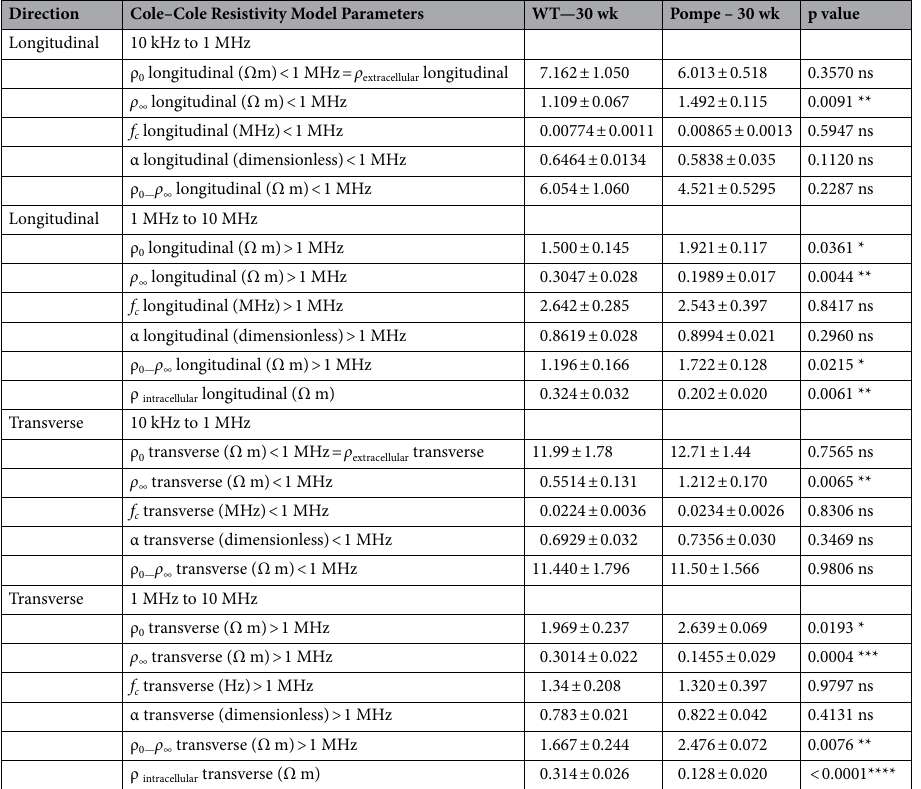
Table 1. Estimated Cole–Cole Resistivity Model Parameters at low frequency (range from 10 kHz to 1 MHz) and high frequency (range from 1 to 10 MHz) including the extracellular and intracellular resistivity, in both longitudinal and transverse directions for the gastrocnemius muscle. All values given as mean ± standard error of mean. Unpaired t test. * p < 0.05; ** p < 0.01; *** p < 0.001; **** p < 0.0001; ns not